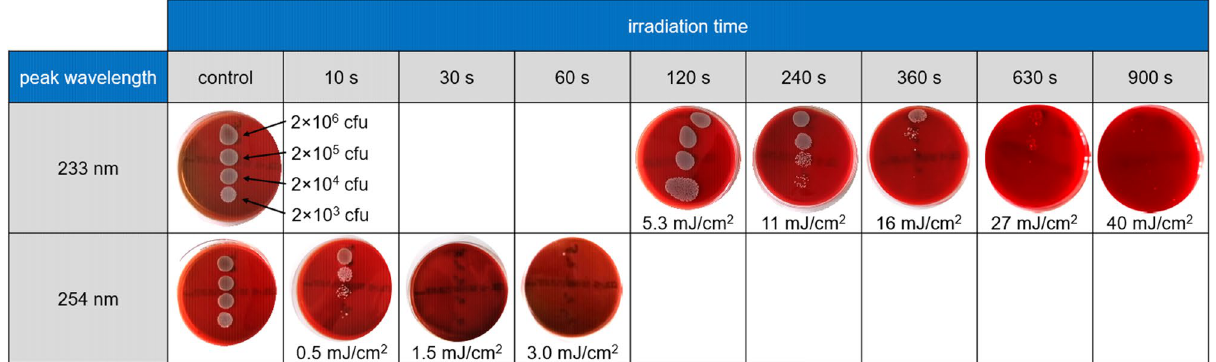
Figure 3. Columbia blood agar plates inoculated with different concentrations of bacterial suspension (MRSA, DSM 11822) without and with UVC irradiation for different times using either far-UVC (233 nm) or near-UVC (254 nm) radiation and after incubation for 24 h. The numbers below the plates indicate the applied UV